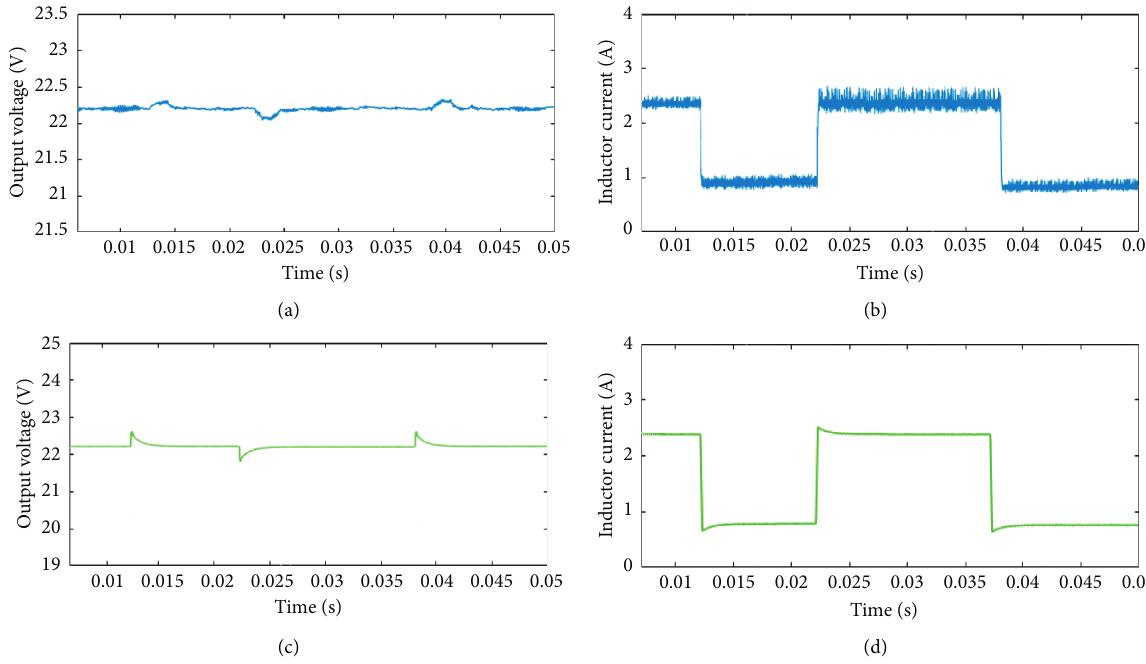
Figure 19: Evaluation of the proposed controller performance under load disturbance: experimentally (a) output voltage and (b) inductor current and in simulation (c) output voltage and (d) inductor current.